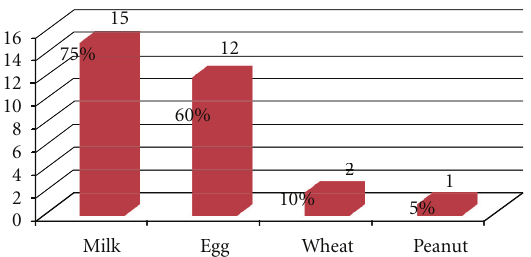
Figure 1: Sensitization to food allergens in the group of symptom- atic infants at 6 months of age ( n = 20).